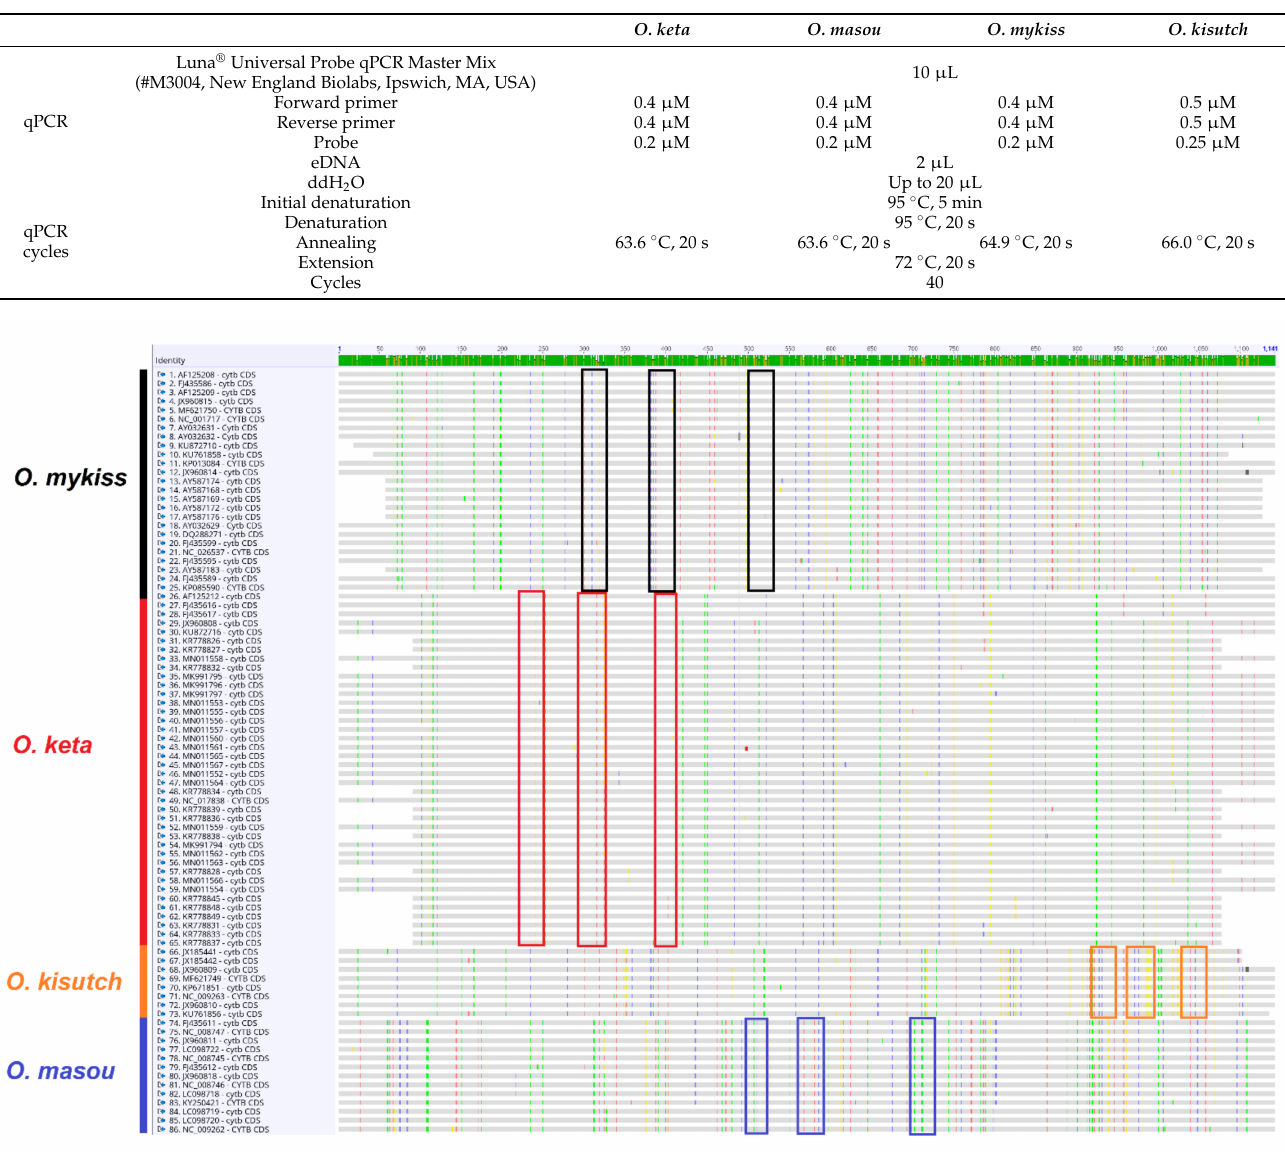
Figure A1. Multiple sequence alignment of primer regions from 86 haplotypes. Left, center, and right boxes indicate forward primer, probe, and reverse primer region, respectively. Each color represents the respective target salmon: O. mykiss (black), O. keta (red), O. kisutch (orange), and O. masou